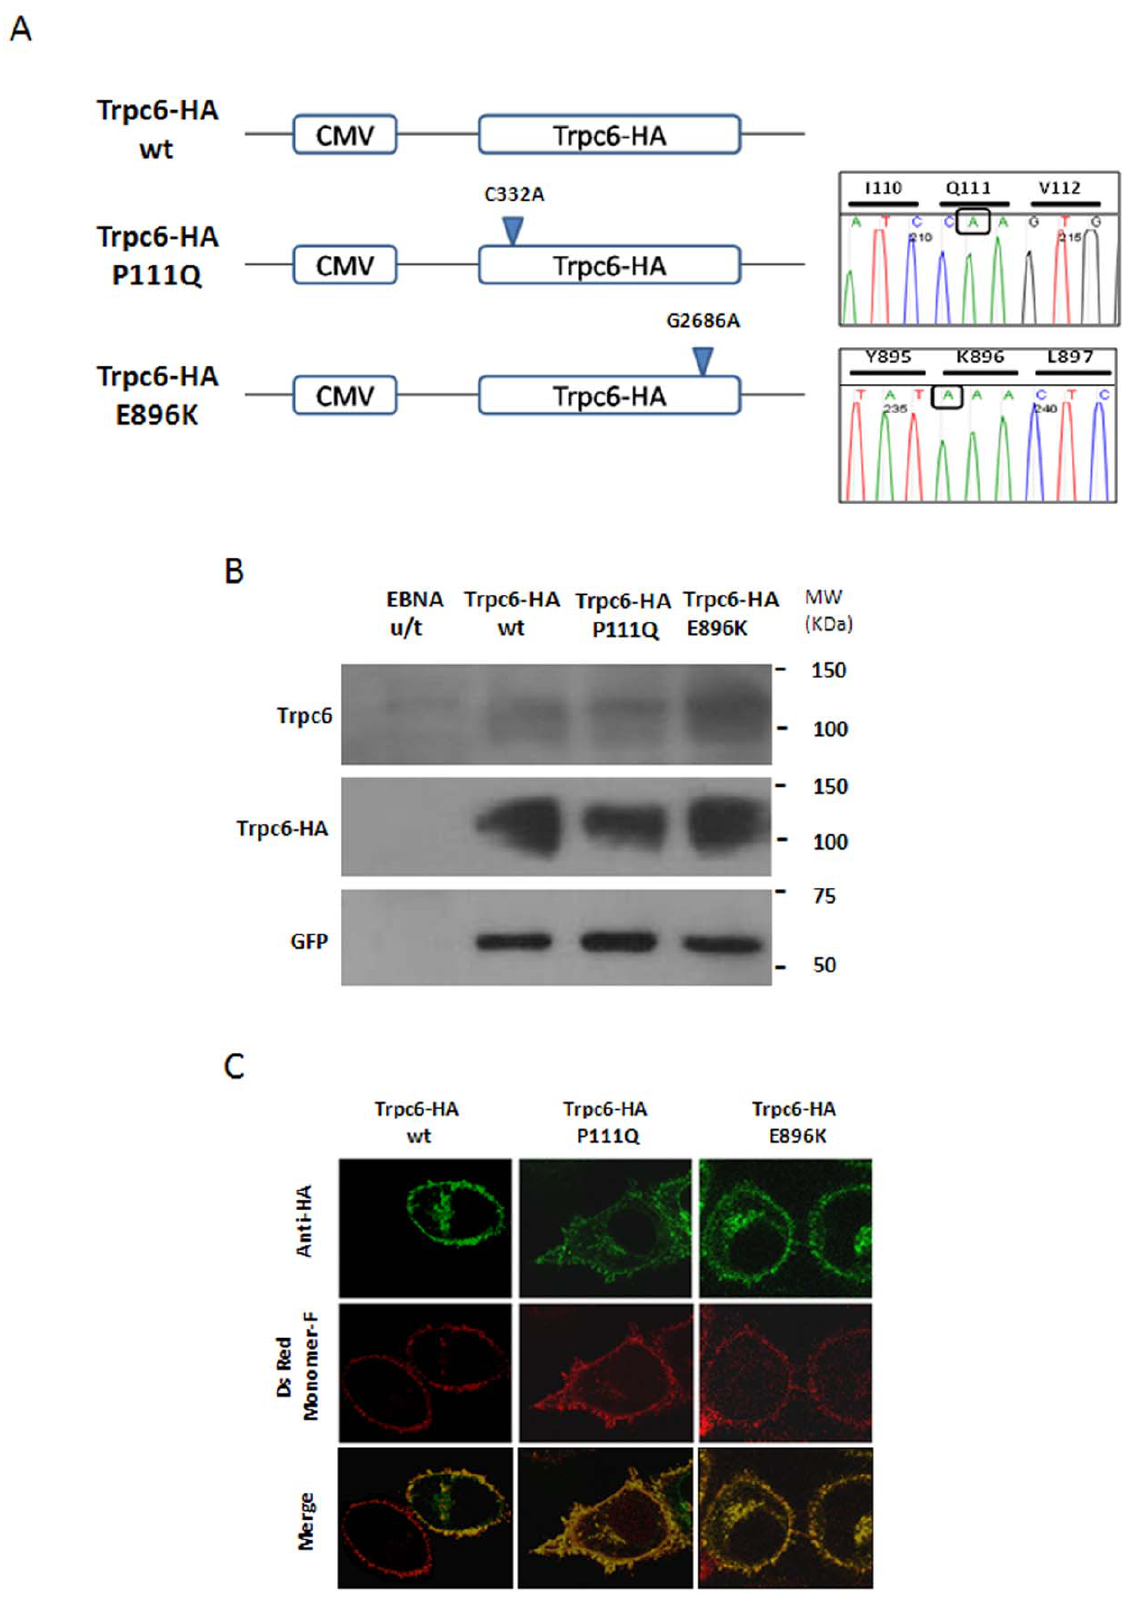
Figure 1. Generation and analysis of modified Trpc6 cDNA’s. (A) Schematic representation of the Trpc6 constructs utilized for the in vitro studies. Chromatograms of mutations C332A and G2683A that generate aminoacid substitutions P111Q and E896K are shown. (B) Lysates from EBNA293 either untransfected (u/t) or transfected with a plasmid containing Trpc6-HA wt, Trpc6-HA P111Q or Trpc6-HA E896K cDNA were analyzed